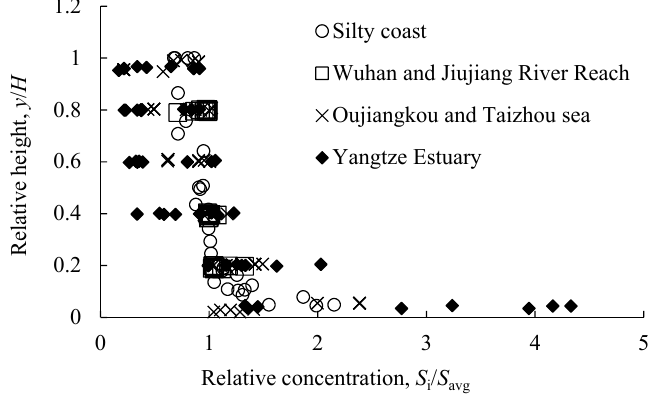
Figure 3. Vertical distribution of sediment concentration measured at different regions. Data at Yangtze Estuary are drawn from Zhang [20], data at Wuhan and Jiujiang River Reach are drawn from Tang et al. [22], data at Oujiangkou and Taizhou sea area are drawn from Dong et al. [21], and data at silty coast are drawn from Xia et al. [24]. S i is the measured concentration of the vertical profile (kg/m 3 ), and S avg represents the vertical averaged concentration (kg/m 3 ).